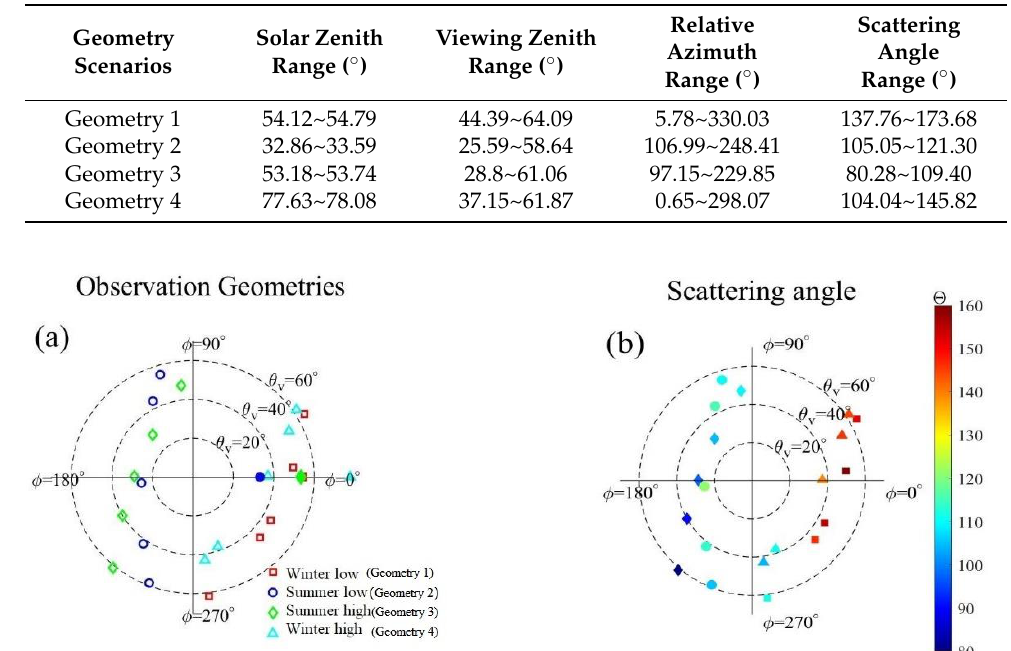
Table 2. Multi-viewing observation geometries for forward simulations (corresponding to Figure 1).